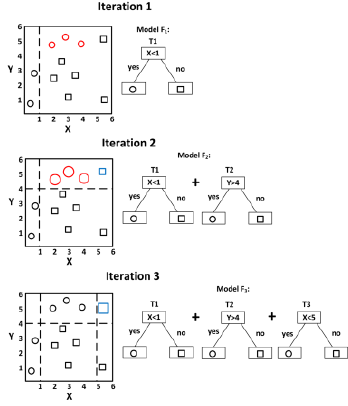
Figure 3 . CART: partitions (left) and decision-tree structure (right) for a classification tree model with three classes c1 , c2 and c3 .